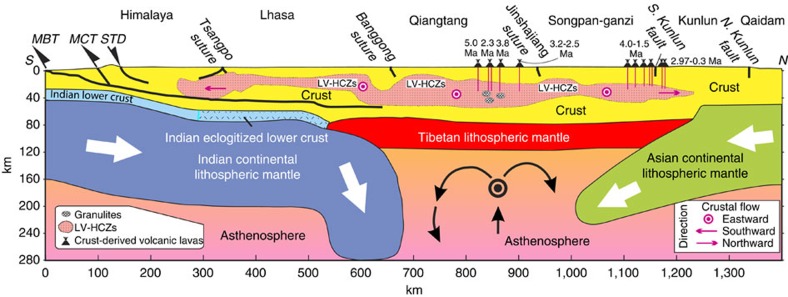
Integrated schematic cross-section across Tibet.This section illustrates one interpretation of the processes operating in the crust and mantle beneath Tibet (refs 1, 8, 15, 20, 21, 24, 28, 29). The Main Boundary Thrust Fault (MBT), the Main Central Thrust Fault (MCT), the Southern Tibet Detachment System (STD), the Tsangpo, Bangong, and Jinshajiang sutures, and the southern and northern Kunlun Faults are after Owens and Zandt1. The convection cell (black circles and arrows) underneath central and northern Tibet is superimposed eastwards (that is, from out of the plane in the figure) (after Tilmann et al.28). The low-velocity–high-conductivity zones (LV–HCZs) in the Tibetan crust are based on the geophysical data across the Tibetan Plateau (refs 1, 8, 15, 17, 20, 21, 22). The age data for Pliocene-Quaternary (4.7–0.3 Myr ago) felsic volcanic lavas are from Supplementary Data set 1.